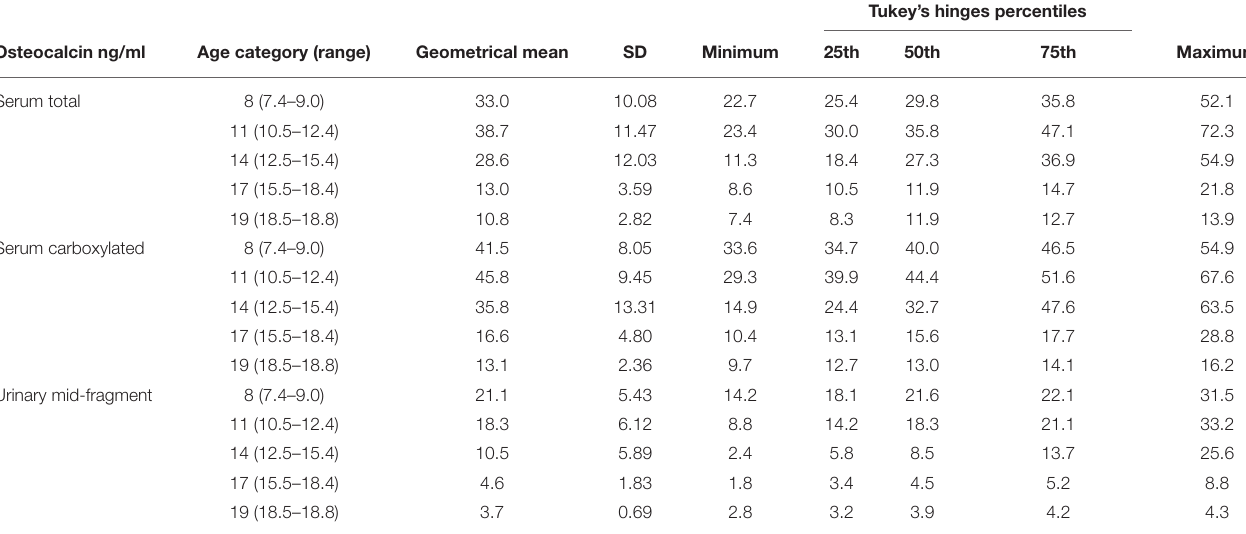
Tukey’s hinges percentiles